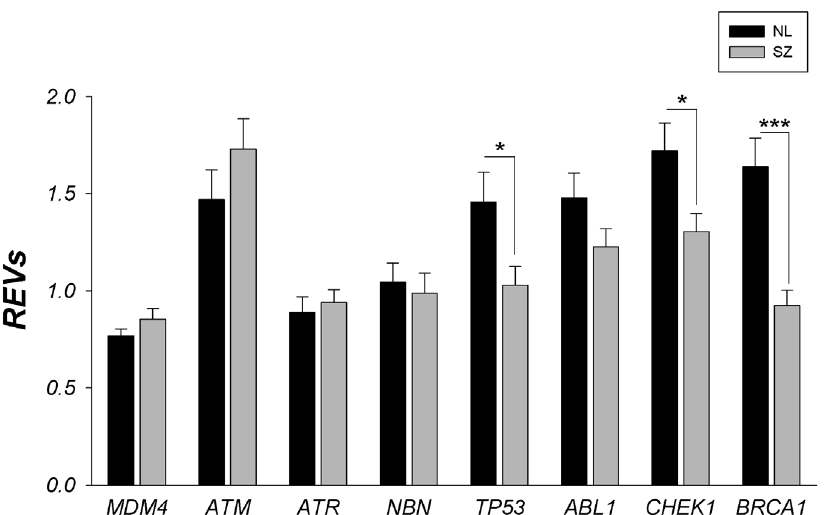
Figure 3. Gene expression changes for ATM/ATR signaling pathway in STG (BA22) in schizophrenia (gray bars) compared to controls (black bars). REVs- relative expression values; NL- controls; SZ- schizophrenia; * - p , 0.05; *** - p , 0.001.